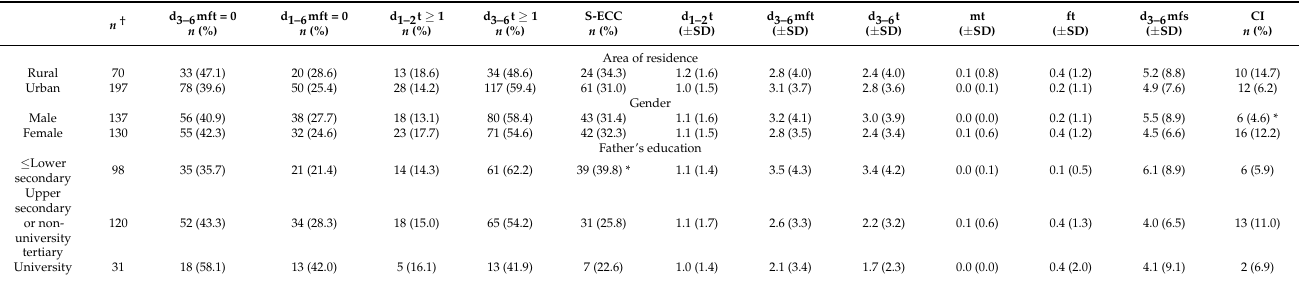
Table 1. Caries prevalence and caries experience of 5-year-old children of immigrant origin in Greece. Number of children ( n ), percentage of caries-free children on the d 3–6 mft level (d 3–6 mft = 0), percentage of caries-free children on the d 1–6 mft level (d 1–6 mft = 0), percentage of children with initial caries (d 1–2 t ≥ 1), percentage of children in need of restorative treatment (d 3–6 t ≥ 1), percentage of children with severe early childhood caries (S-ECC), mean ICDAS 1–2 on the tooth level (d 1–2 t) mean d 3–6 mft and its components (d 3–6 t, mt, ft), mean d 3–6 mfs and Care Index (CI, %) on the tooth level, according to the area of residence, gender and parents’ educational